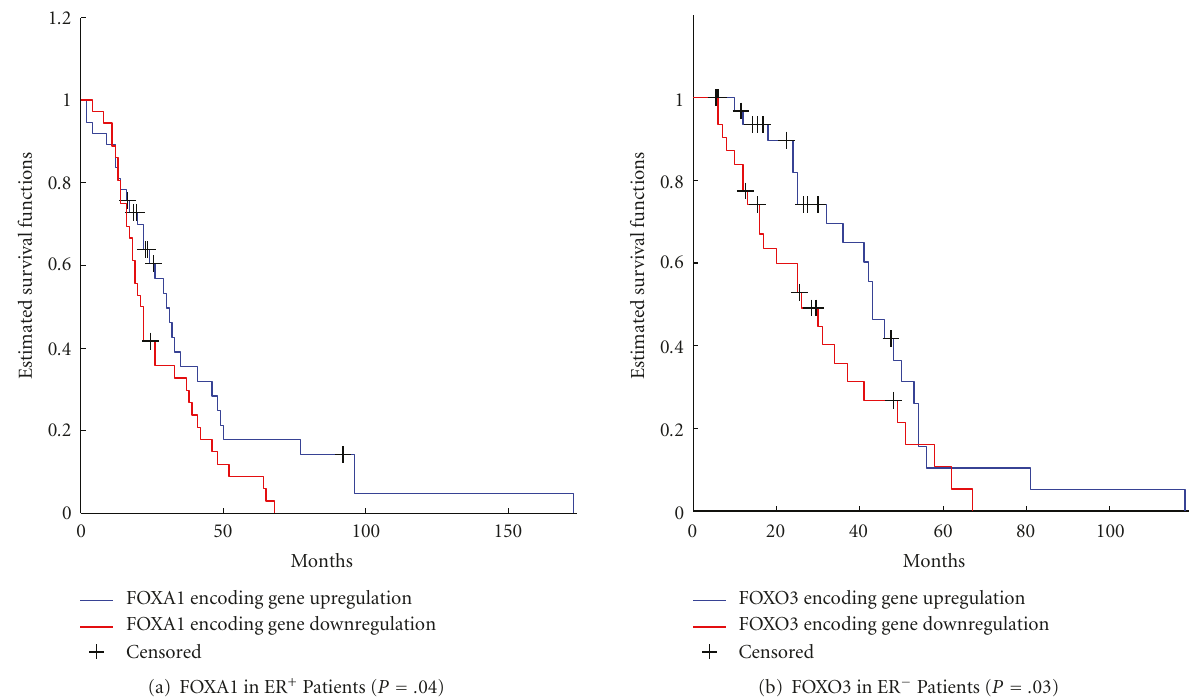
Figure 14: Kaplan-Meier survival estimates for FOXA1 in ER + and FOXO3 in ER − are significantly di ff erent.